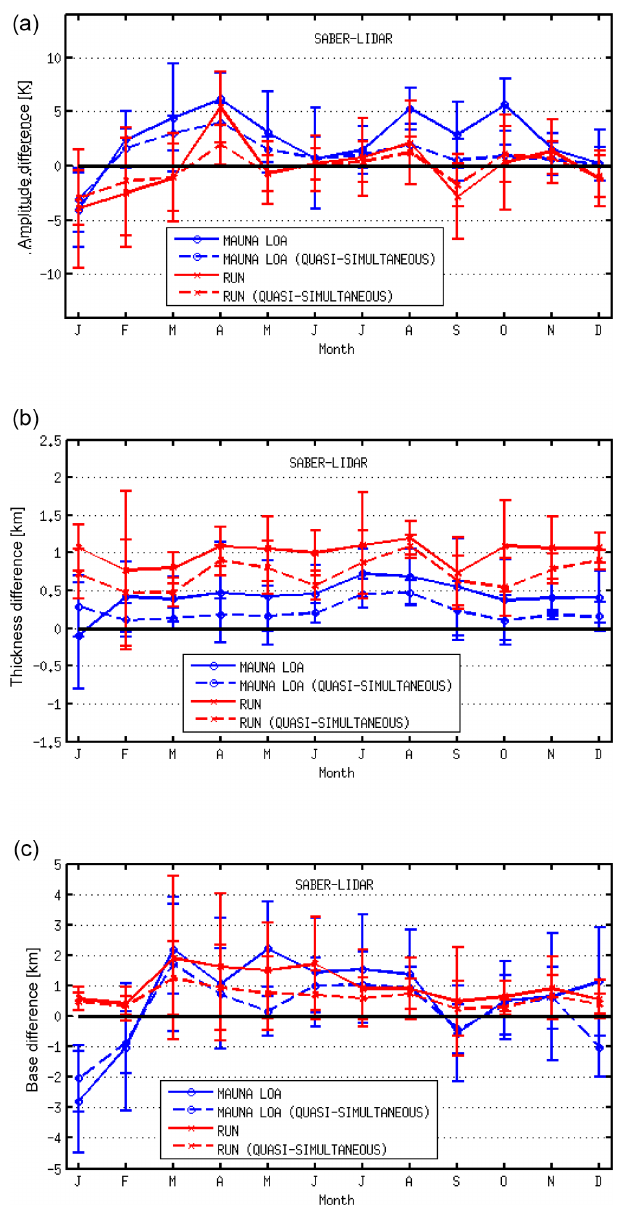
Figure 6. Mean monthly difference and standard deviation of (a) amplitude, (b) thickness and (c) base of the inversion between lidar and nearest SABER coincidences (dashed line) and whole SABER observations (solid line) over Mauna Loa during 2002– 2014 (blue line) and over Réunion during 2002–2009 (red